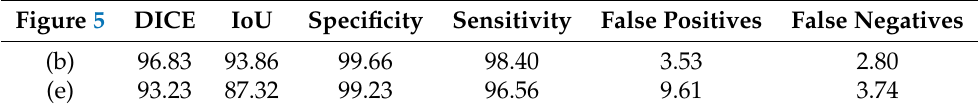
Figure 5. Male subject with variable degree of deformation in both feet. The upper row illustrates the workflow described in Figure 2 for the left foot whereas the lower one corresponds to the right foot. The first column, ( a , d ), displays the original IR images and the corresponding segmentation (pink mask). The second column, ( b , e ), shows the segmentation registered to and overlapped with the left and right models, respectively. The third column, ( c , f ), illustrates the final result in which the segmentation is applied to the original IR image for further processing. Table 6. Overlap measures between the model, associated with the left and right feet, for a male subject presenting deformation in both feet. Average values are expressed as